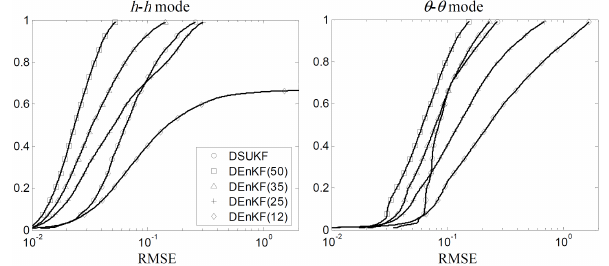
Figure 6. Cumulative probability distribution of the RMSE of DSUKF and DEnKF with 50, 35, 25 and 12 ensemble members for both the h - h and θ - θ